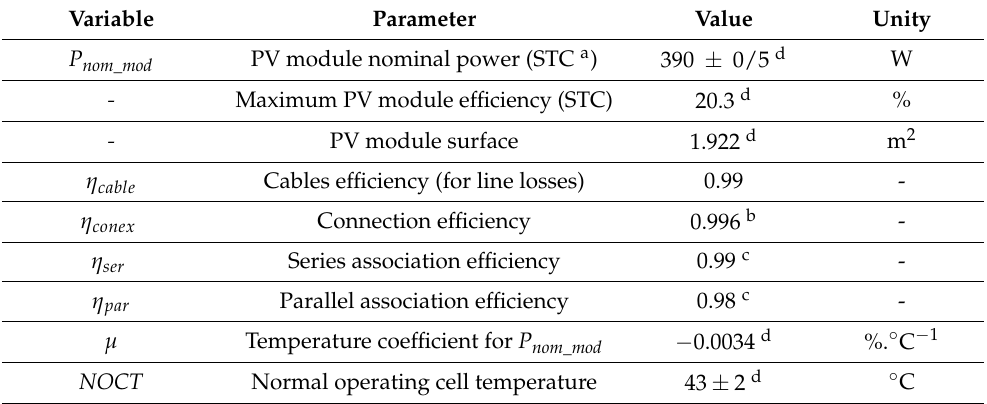
Table 2. Technical characteristics of the PV module (TrinaSolar, module VertexS TSM-390 DE09.08, Mono-Si) and the PV power